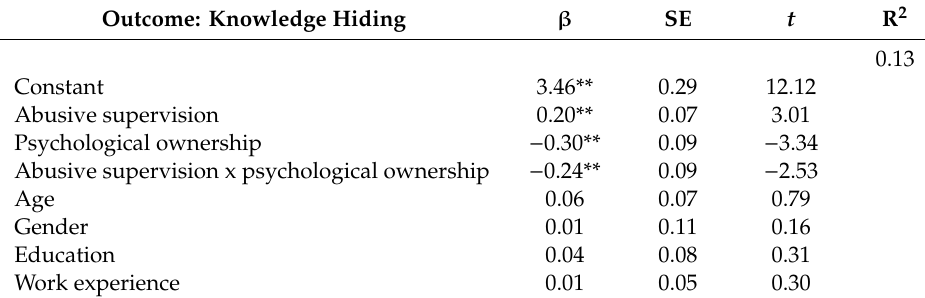
Table 5. Moderation e ff ect.